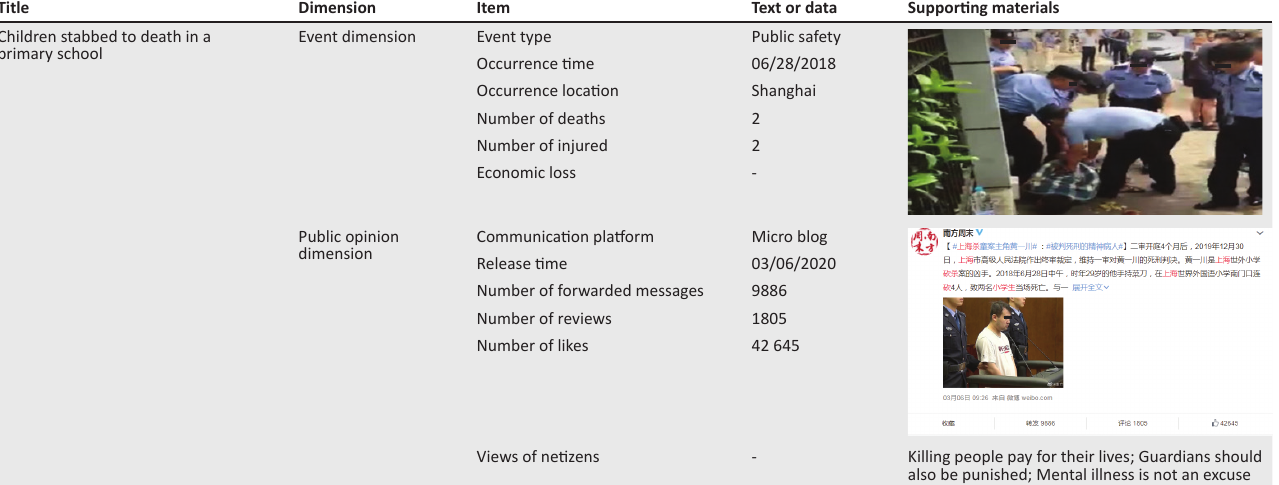
TABLE 1: The collected data of a specific case (example). Title Dimension Item Text or data Supporting materials Children stabbed to death in a primary school